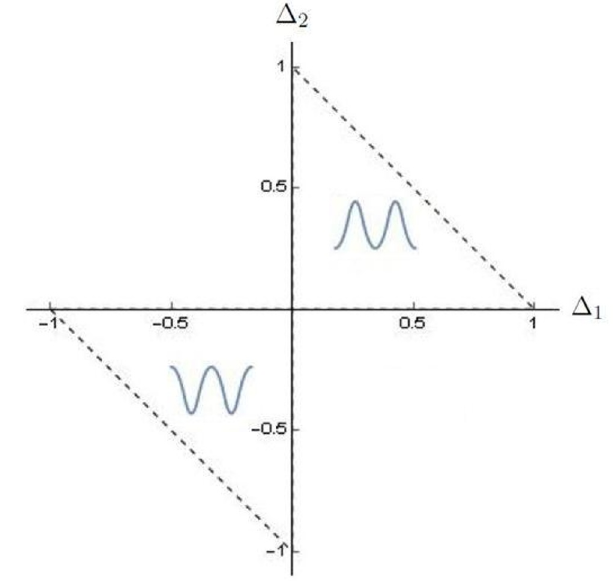
Figure 1. The qualitative behavior of the pairwise potential for the holonomies, as a function of the pair’s separation, for (cid:12)xed (cid:1) 1 ; 2 and (cid:12)xed arg (cid:12) 2 (0 ; (cid:25)= 2), in the two complementary regions (cid:0) 1 < (cid:1) 1 ; (cid:1) 2 ; (cid:0) 1 (cid:0) (cid:1) 1 (cid:0) (cid:1) 2 < 0 (lower-left) and 0 < (cid:1) 1 ; (cid:1) 2 ; 1 (cid:0) (cid:1) 1 (cid:0) (cid:1) 2 < 1 (upper-right) of